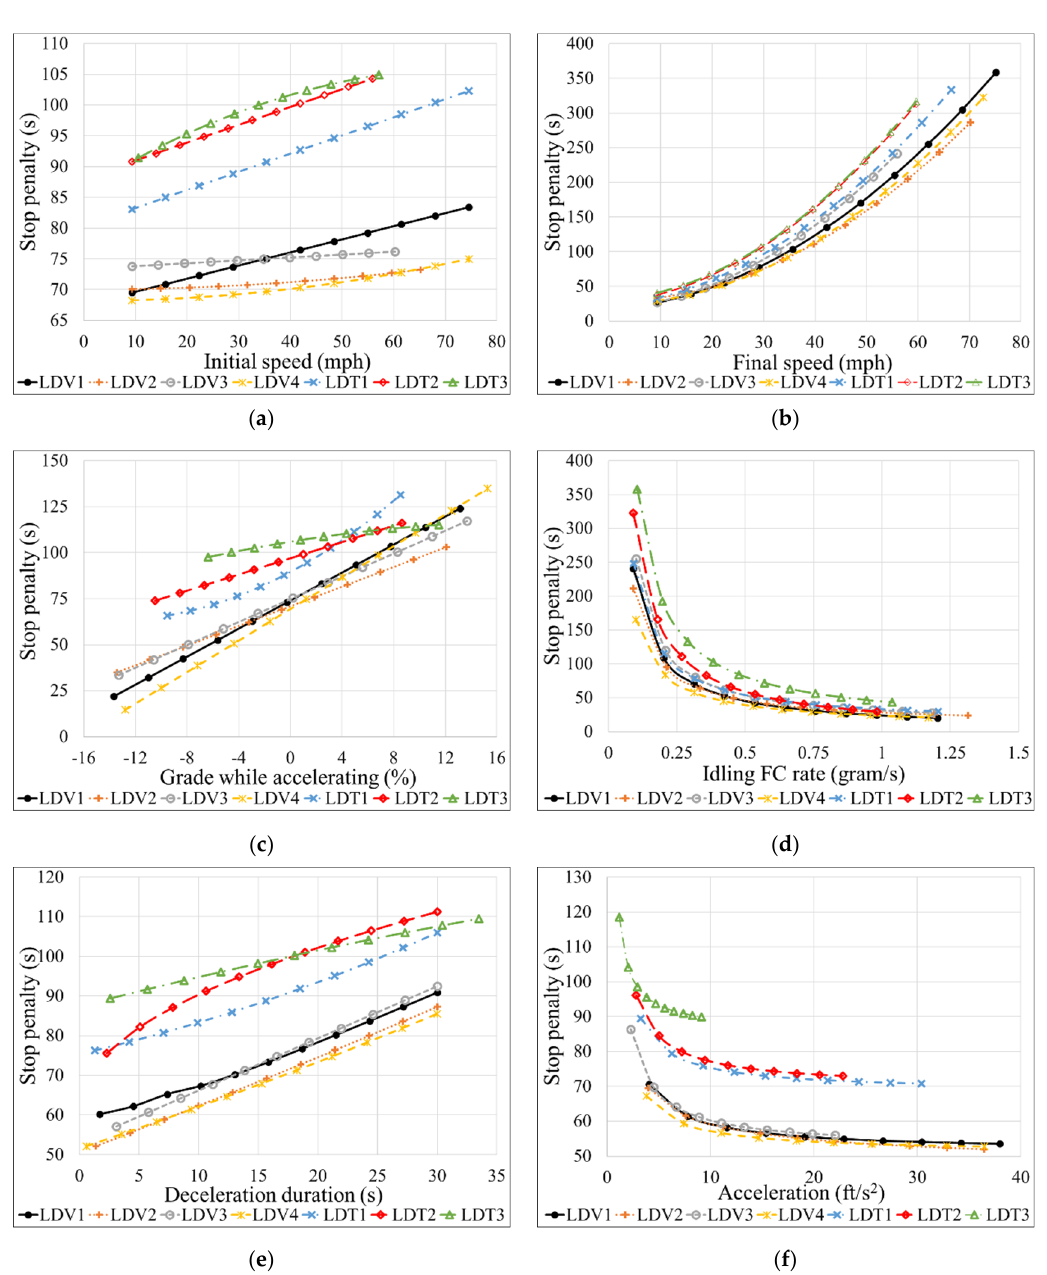
Figure 10. Parametric analysis of the developed models. ( a ) Initial speed vs. stop penalty; ( b ) Final speed vs. stop penalty; ( c ) Accelerating grade vs. stop penalty; ( d ) Idling FC rate vs. stop penalty; ( e ) Deceleration duration vs. stop penalty; ( f ) Acceleration vs. stop penalty.